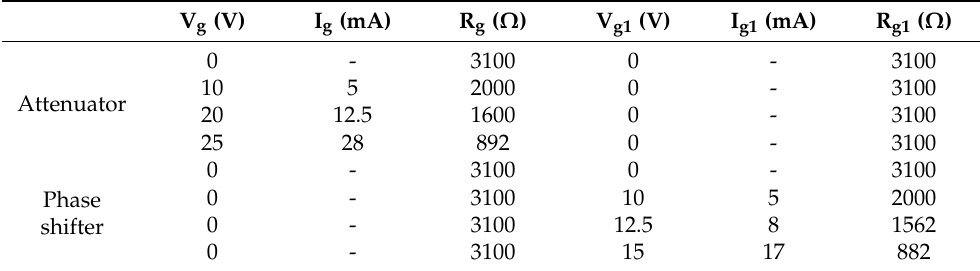
Table 1. Values of the voltage, current and resistance of the attenuator and phase